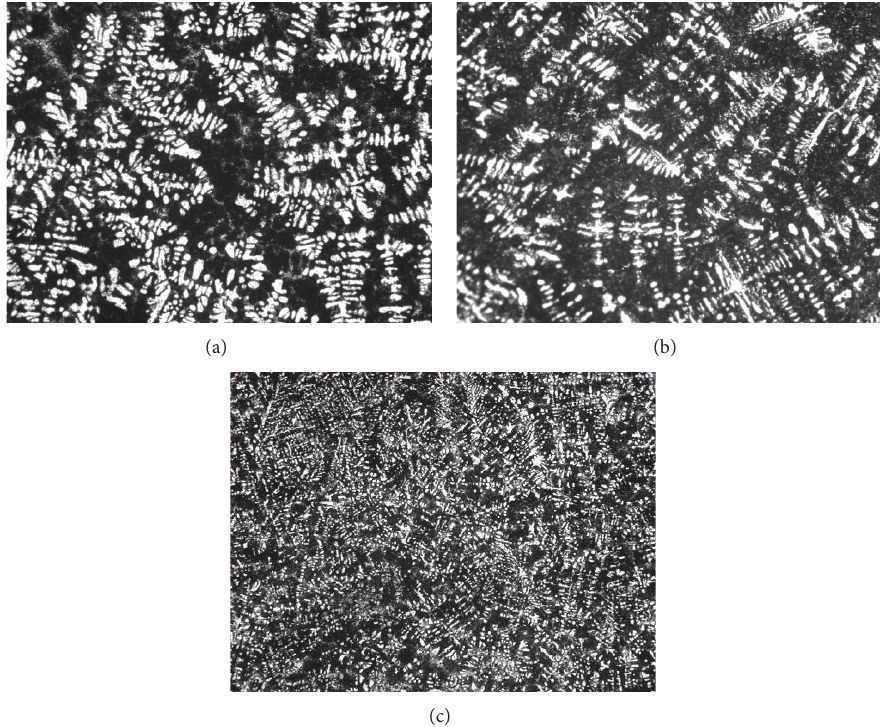
Figure15:Microstructureatsqueezecastingprocess:(a)70MPa,(b)105MPa,and(c)140MPaofsqueezepressure(diepreheatedtemperature and melt temperature are 225 ∘ C and 725 ∘ C which are fixed) at 100x